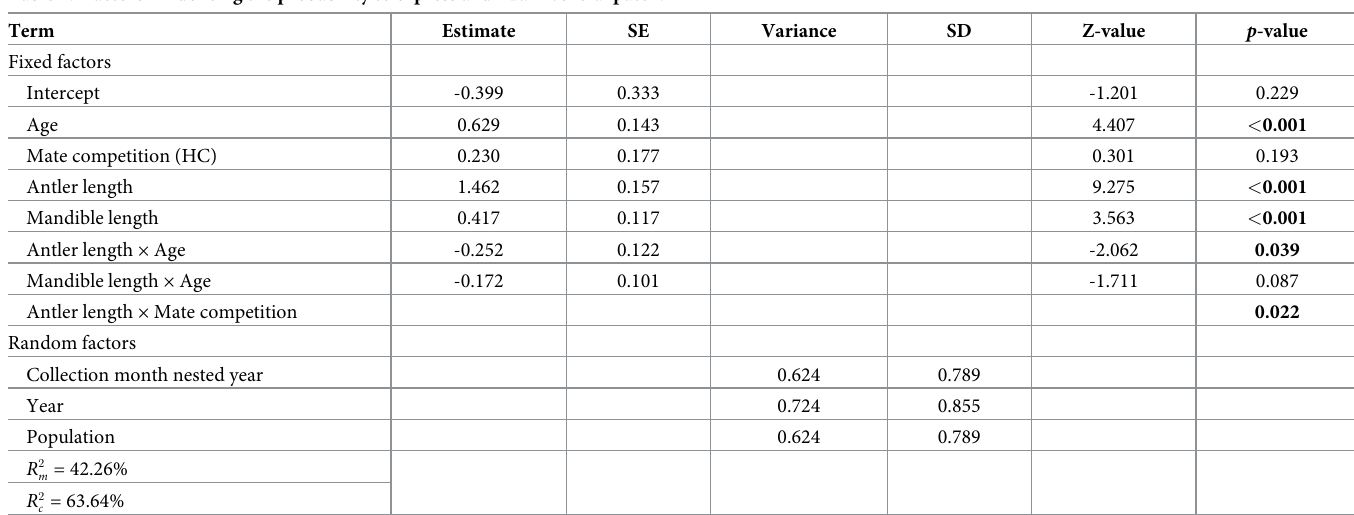
Table 2. Factors influencing the probability to express a full dark ventral